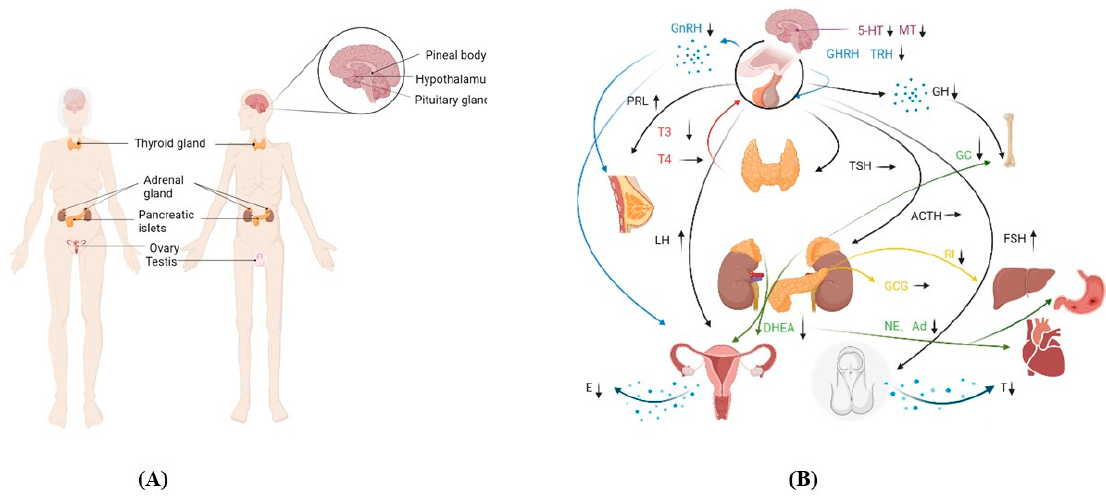
Figure 5. Changes in the function of endocrine glands. ( A ) Endocrine glands in the body. ( B ) Changes in hormone secretion and the action of endocrine organs. The same color curve represents the same endocrine gland, and the arrow is typically used for a particular organ . Abbreviations: 5-hydroxytryptamine (5-HT), melatonin (MT), gonadotropin-releasing hormone (GnRH), thyrotropin-releasing hormone (TRH), prolactin (PRL), growth hormone (GH), thyroid-stimulating hormone (TSH), adrenocorticotropic hormone (ACTH), follicle-stimulating hormone (FSH), triiodothyronine (T3), tetraiodothyronine (T4), dehydroepiandrosterone (DHEA), glucocorticoids (GC), noradrenalin (NE), adrenalin (Ad), insulin (INS), glucagon (GCG), estrogen (E), and testosterone (T).